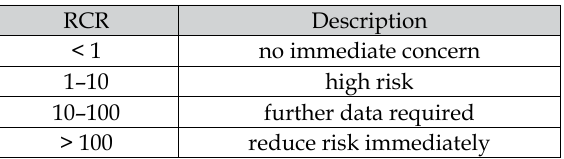
Table 2. RCR is used as an indicator of